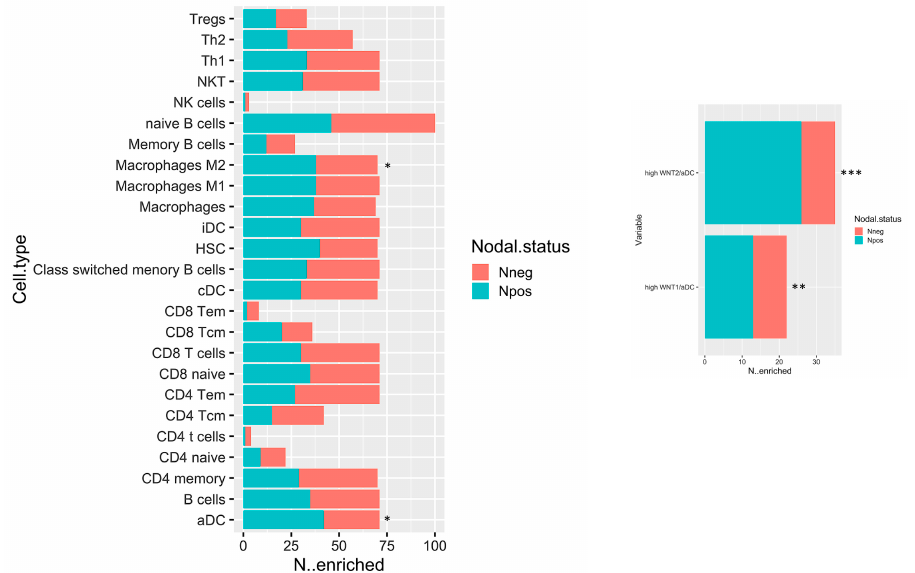
Figure 5. Bar plot displaying the number of cases which have enrichment value above the selected cut-off (median of enrichment scores) relative to N pos and N neg cases. * p < 0.05; ** p < 0.05; and *** p < 0.001.